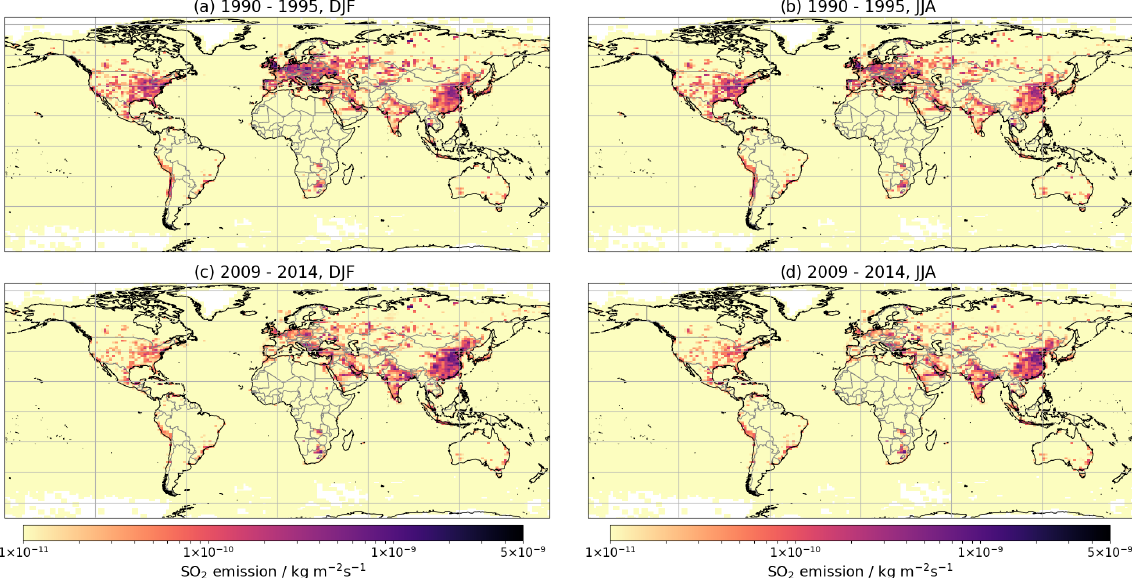
Figure B1. Global emissions of SO 2 used in UKESM1. Mean seasonal emissions are shown for the 1990–1995 time slice for DJF (a) and JJA (b) and the 2009–2014 time slice for DJF (c) and JJA (d)